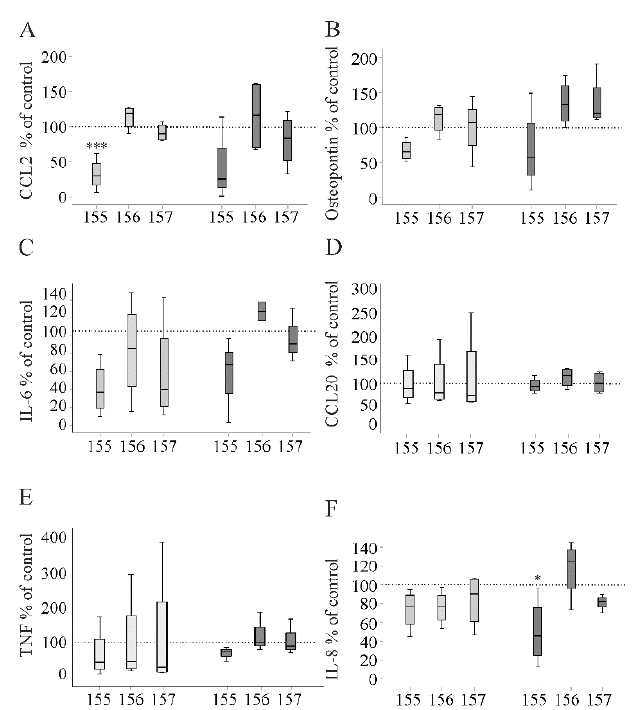
Figure 8. Proteins measured in the media of peripheral blood mononuclear cells (PBMCs) cultivated in Huh7 cell-conditioned medium by ELISA. ( A ) CCL2; ( B ) osteopontin; ( C ) IL-6; ( D ) CCL20; ( E ) TNF; ( F ) IL-8. Light gray boxes are cells without and dark gray boxes are cells with 100 ng/ml lipopolysaccharide in the cell media. Data were analyzed with one-way ANOVA with post-hoc Tukey test or the Welch test with post-hoc Games–Howell test. * p < 0.05; *** p < 0.001; compared to control-cultivated PBMC, which were set to 100% (dotted line), n = 4.